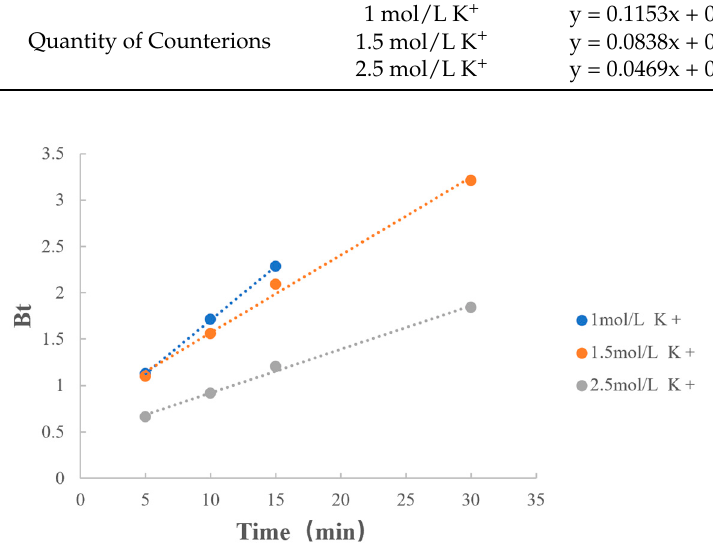
Figure 10. Boyd model fitting on the concentration of counterions.